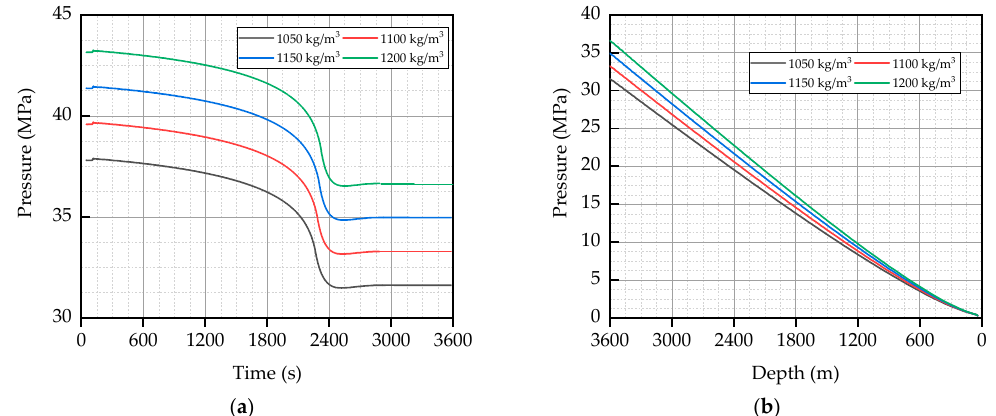
Figure 18. Variation in the bottom hole pressure at different liquid densities at different: ( a ) times; and ( b ) depths.